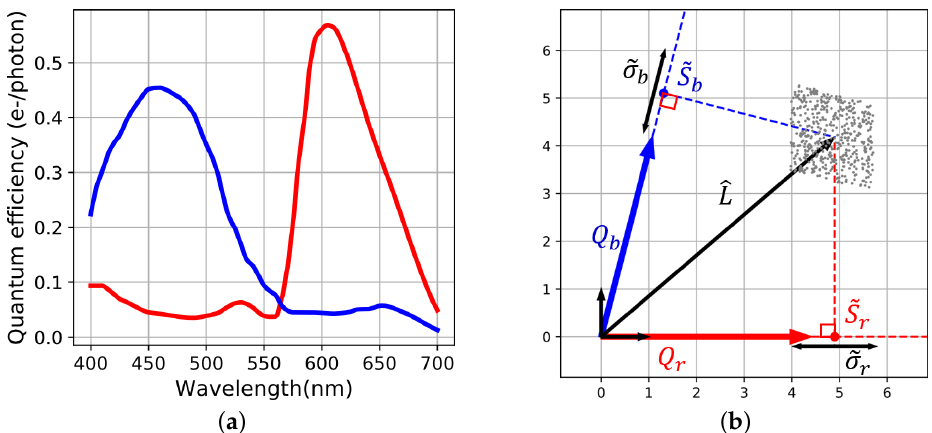
Figure 6. ( a ) Spectral sensitivities of the sensor, ( b ) Noisy intrinsic spectral reconstruction (without training set), the positions of reconstructed spectra from pixels of Figure 5 constitute the cloud of points. (cid:98) L is the position of the noise free spectral reconstruction. Its orthogonal projections on Q r and Q b is (cid:101) S r and (cid:101) S b . The size of the noise parallelogram is given by ˜ σ r and ˜ σ b . The area A of the parallelogram represents the level of noise of the spectral